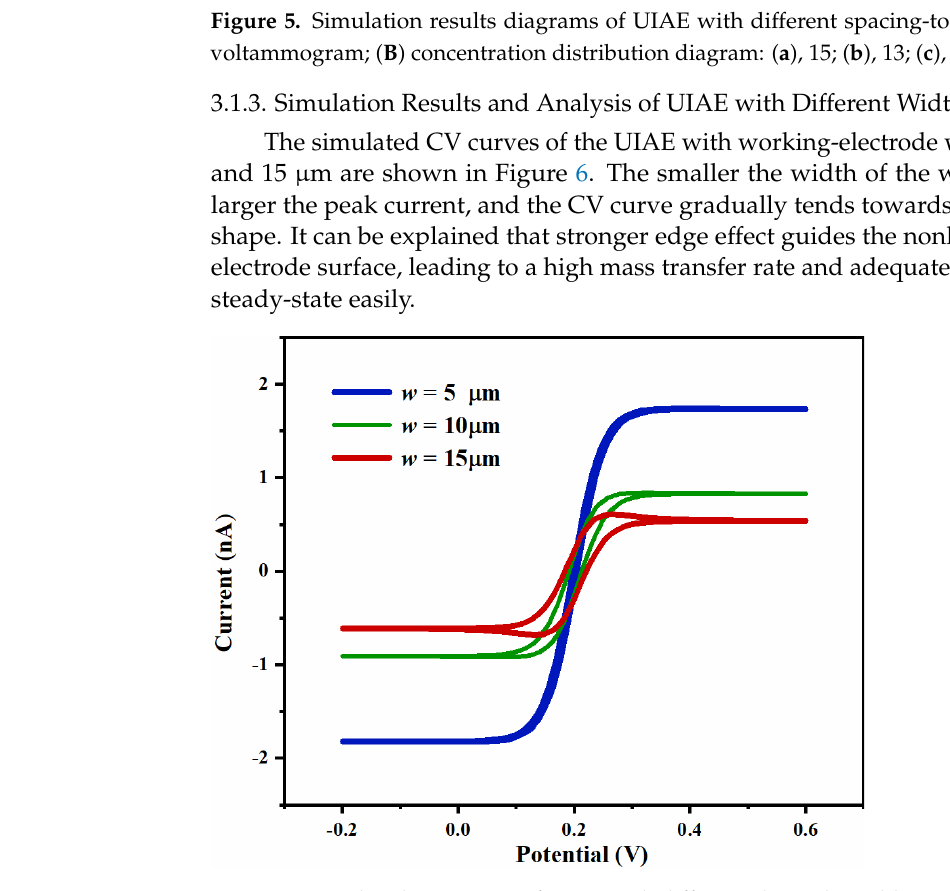
Figure 5. Simulation results diagrams of UIAE with different spacing-to-width ratios: ( A ) cyclic voltammogram; ( B ) concentration distribution diagram: ( a ), 15; ( b ), 13; ( c ), 11; ( d ), 9; ( e ), 7; ( f ), 5.